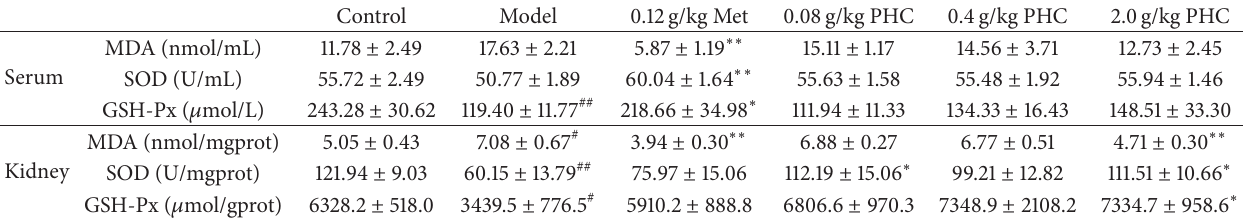
Table 3: The regulatory effects of Met and PHC on the oxidative damage related factors in diabetic